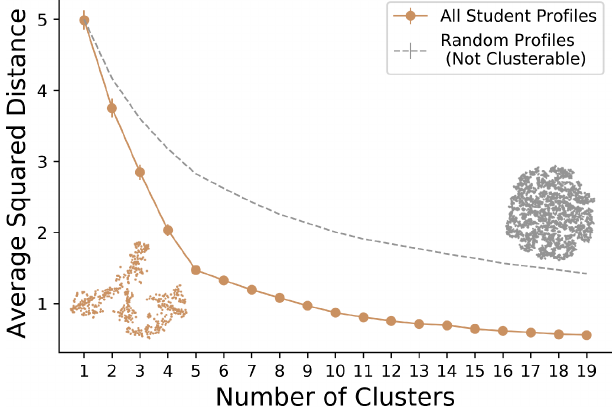
FIG. 3. Elbow plot used to determine the optimal number of clusters for the data. The average squared distance from each point to the center of its assigned cluster is plotted as a function of the number of clusters. There is a kink at five, indicating that the optimal number of clusters for the data is five. Our results were compared against 10 000 randomly generated student profiles.